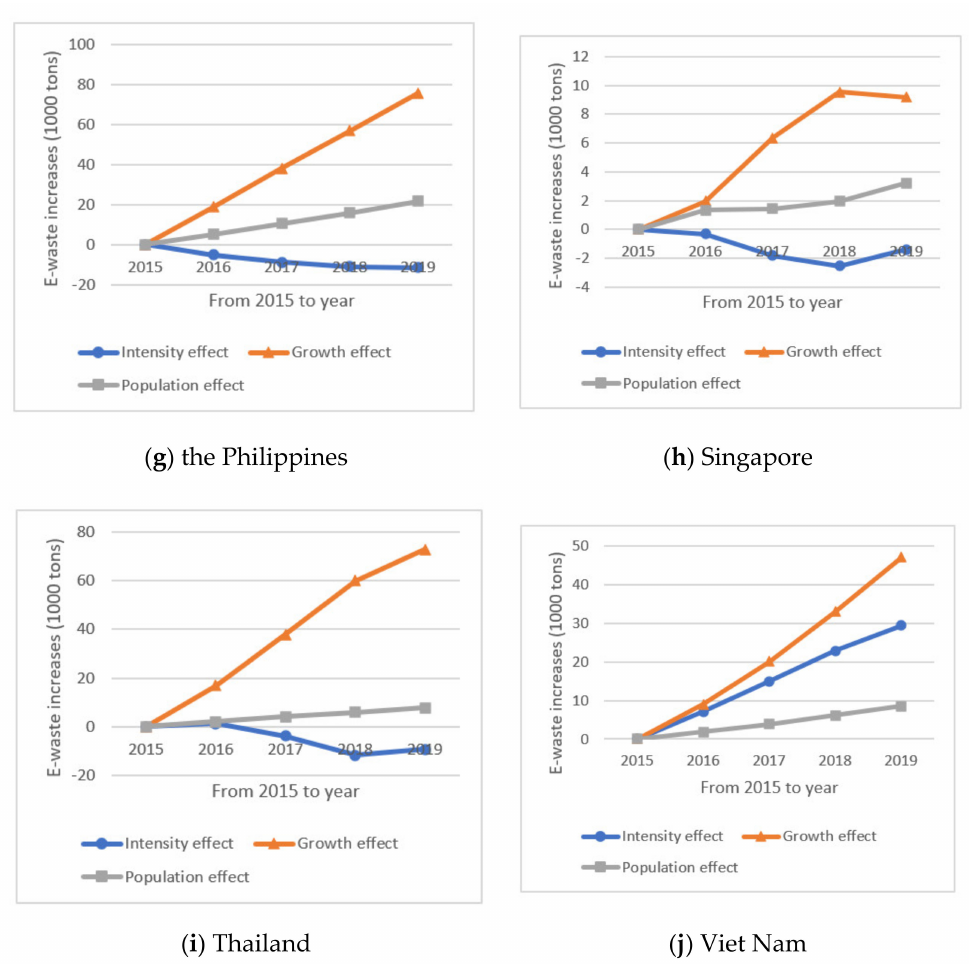
Figure A1. The results of additive LMDI decomposition analysis from 2015 to each comparison year: ( a ) Brunei Darussalam; ( b ) Cambodia; ( c ) Indonesia; ( d ) Lao PDR; ( e ) Malaysia; ( f ) Myanmar; ( g ) the Philippines; ( h ) Singapore; ( i ) Thailand; ( j ) Viet